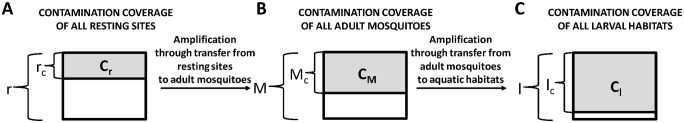
A schematic illustration of how partial coverage all resting sites is amplified in two steps as PPF contamination is transferred to the adult mosquito population and then onwards to the larval habitats.The proportional coverage of the resting sites (C
r), ovipositing adult mosquito population (C
M) and larval habitats (C
l) is depicted as a proportion of all resting sites (r), adult mosquitoes (M) and larval habitats (l) covered with PPF contamination (c).